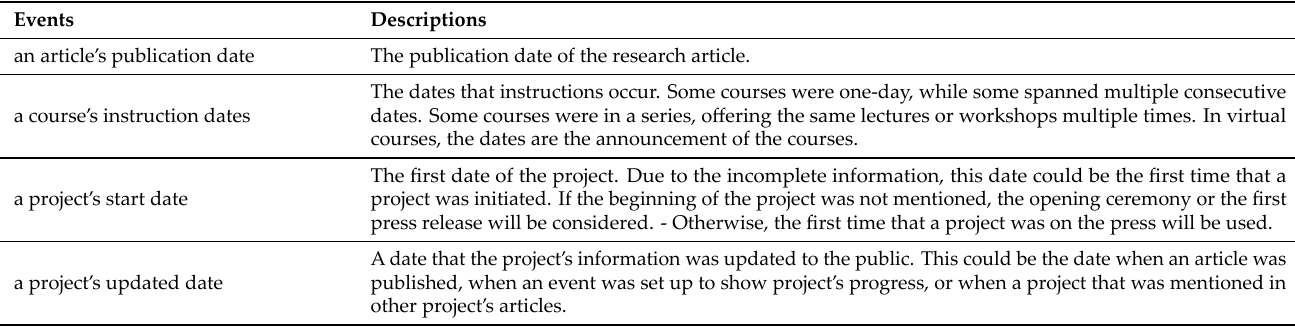
Table 6. A table of events and their